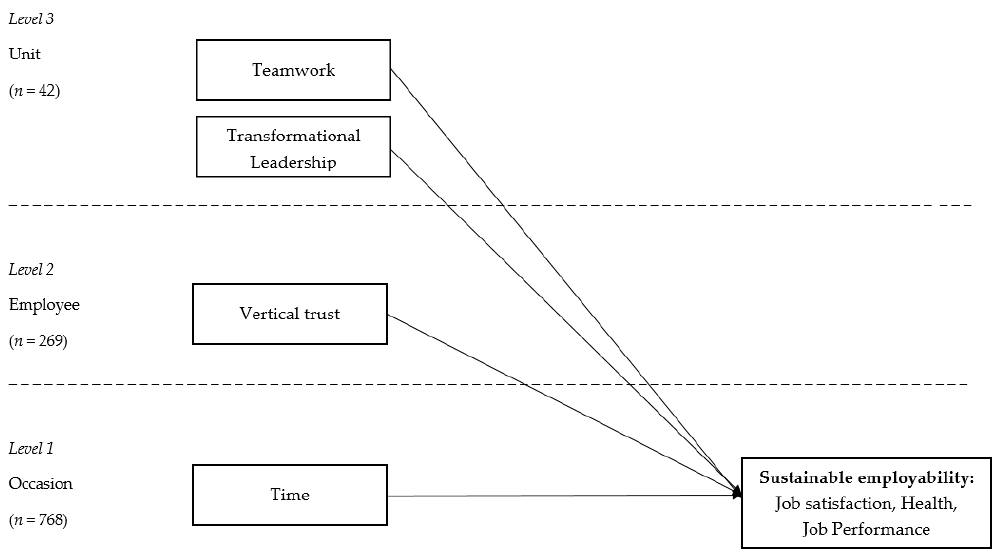
Figure 1. Conceptual model and measurement levels.